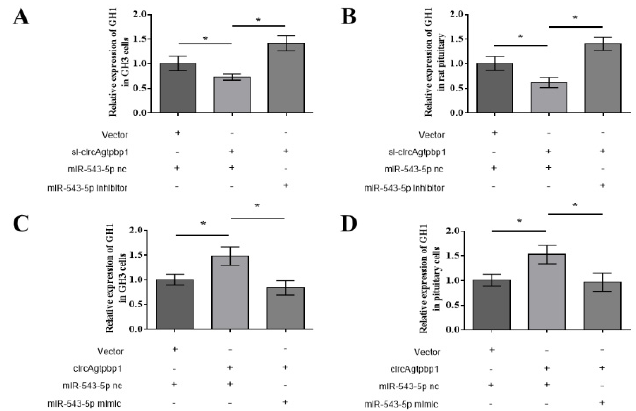
Figure 6. CircAgtpbp1 regulates Gh1 expression and GH secretion via targeting miR-543-5p. ( A , C ) The expressions of Gh1 were detected by qRT–PCR after regulating circAgtpbp1 or miR-543-5p in GH3 cells. ( B , D ) The expressions of Gh1 were detected by qRT–PCR after regulating circAgtpbp1 or miR-543-5p in pituitary cells. At least three replicates of each experiment were performed. Mean values and standard deviations (SD) of data are shown. One-way ANOVA and independent-samples t-test were applied to determine statistical significance. p < 0.05 was considered significant. *, p < 0.05.